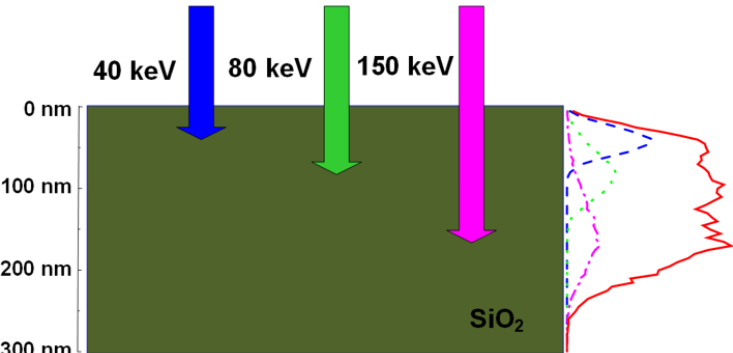
Figure 5. Schematic diagram for the multiple Si ion-implantation with different dose concentrations and implantation energies into SiO 2 layer to form the Si-QDs.